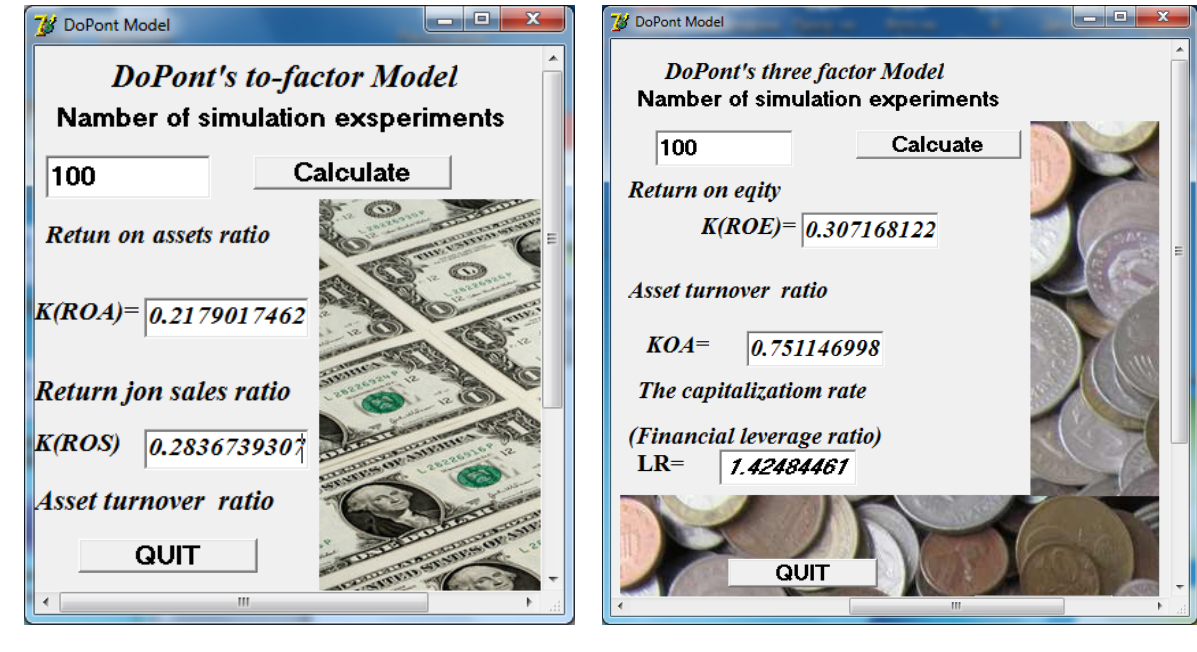
Figure 3. The results of factor analysis of financial.